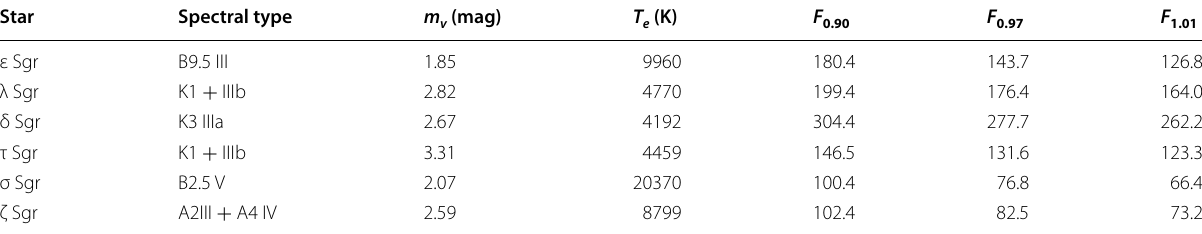
m v is visual magnitude; T e is effective temperature in K; F 0.90 , F 0.97 and F 1.01 are energy fluxes at 0.9, 0.97 and 1.01 μm, respectively, in units of 10 − 12 mW/cm 2 /µm